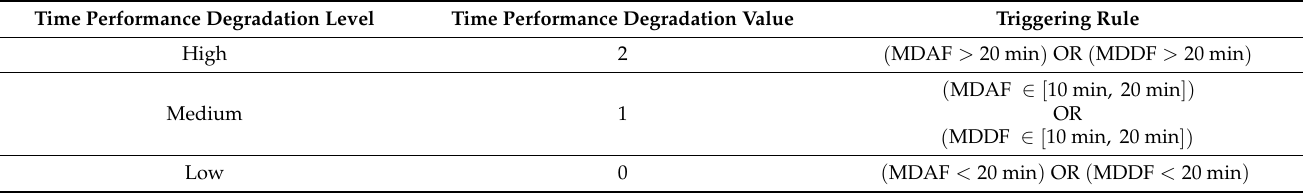
Table 9. Time performance degradation metric.